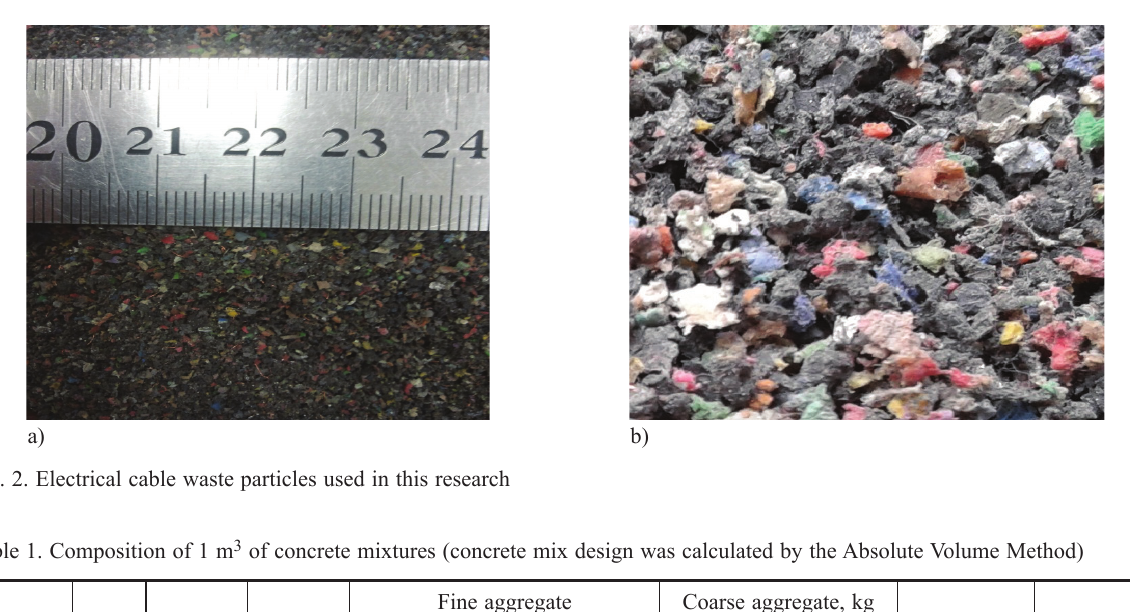
samples W/c Water, l